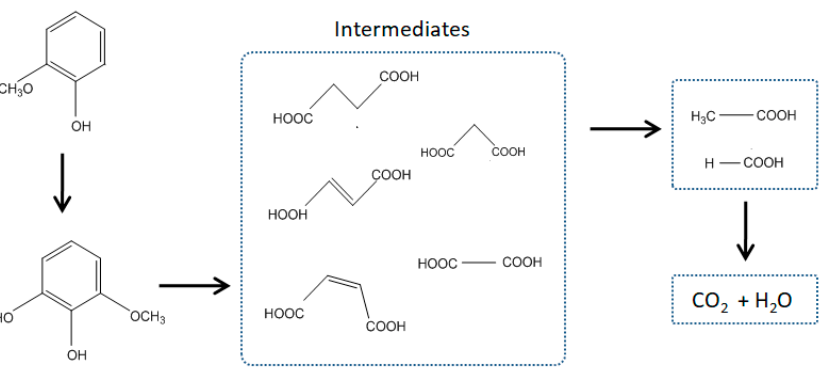
Figure 8. Proposal reaction pathway of guaiacol oxidation under hydrothermal conditions.